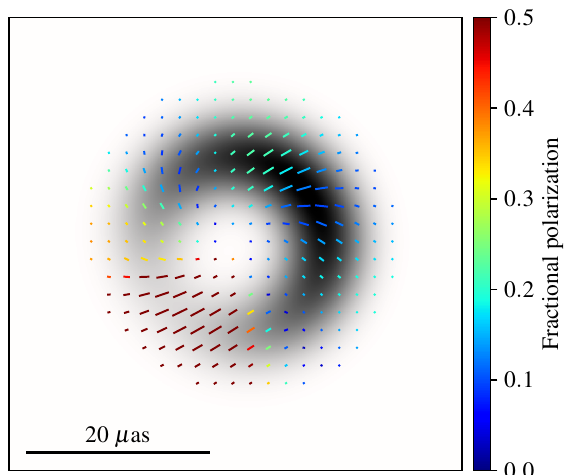
Figure 1. Example polarized source model used for generating the synthetic data described in Section 3. The grayscale image shows the Stokes I emission, while the colored ticks mark the EVPA of the linear polarization structure. The length of each tick is proportional to the intensity of the linear P polarization (i.e., ), while the color of each tick reflects the fractional polarization (i.e., | |